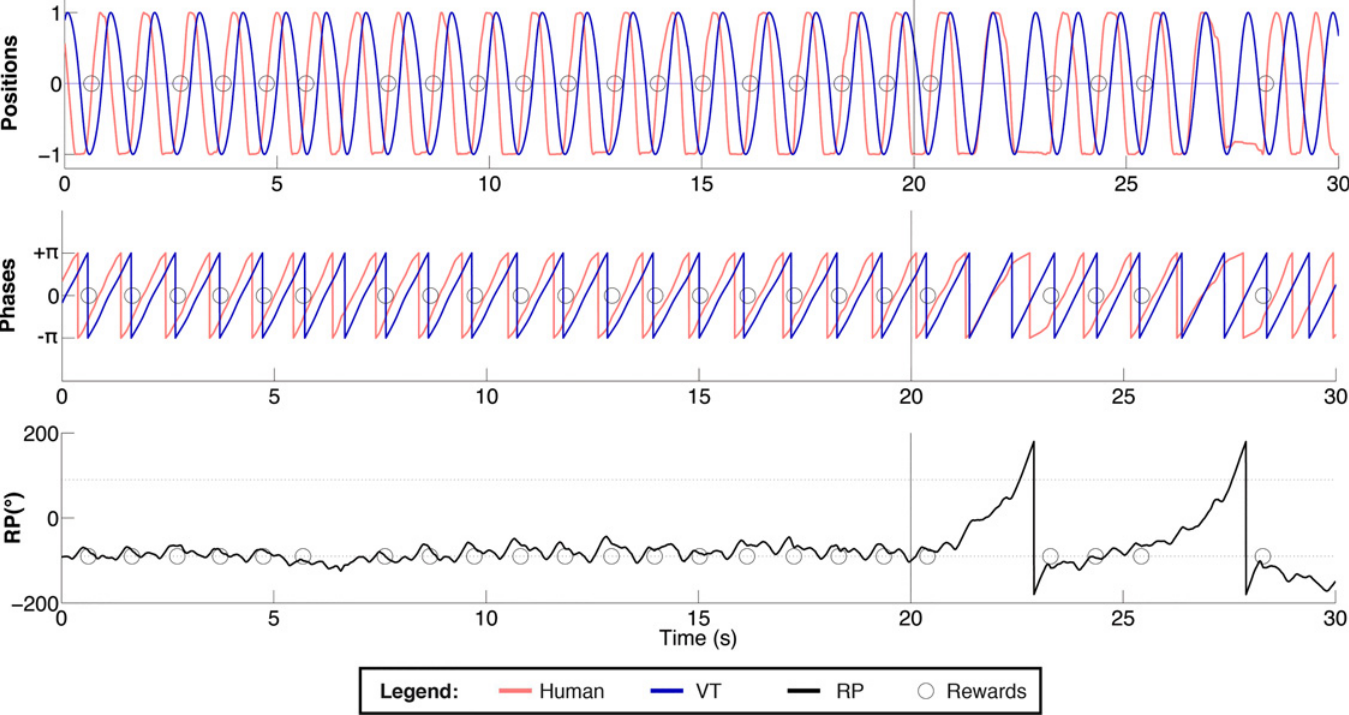
Fig 6. Individual practice trial. Normalized positions (top panel), phases (middle panel) and RP (bottom panel) are displayed as a function of time. Red lines pertain to human, blue to VT; the gray line depicts the RP specified by the VT (90° or -90°); the circles indicate the moment of feedback delivery. The vertical bar located at 20 s denotes the end of the Exposition and the beginning of the Memory